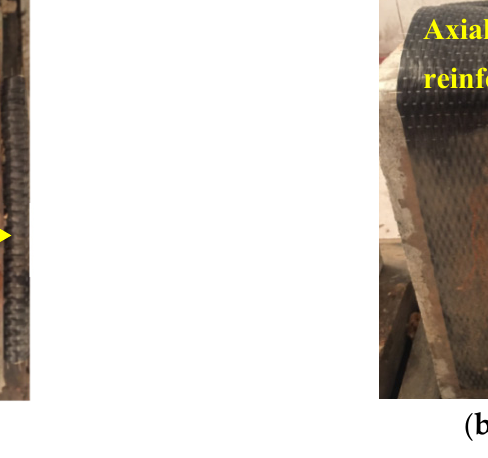
Radial direction of steel bar